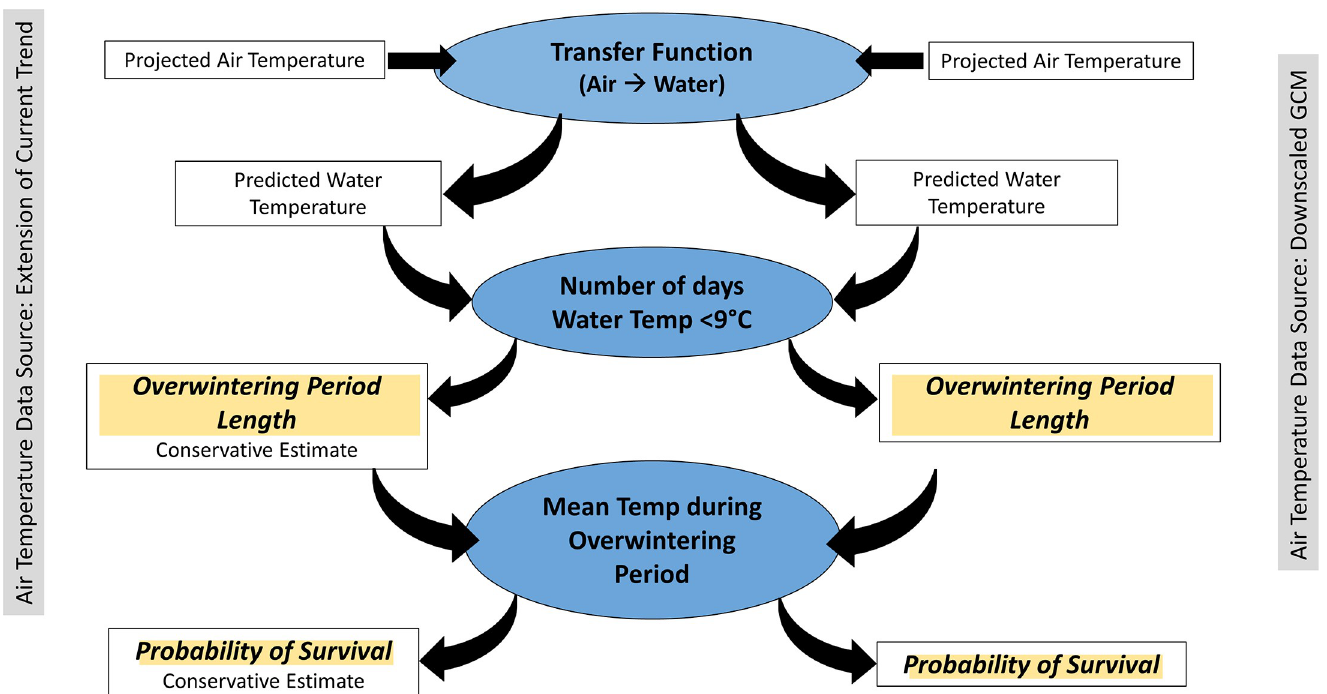
Fig 1. Schematic of the utilization of the transfer function to predict the length of the overwintering period and the winter survival of blue crab through the year 2100. Daily projected air temperature was accessed from two sources: a conservative extension of the observational trend of increasing water temperature in the historical data (left side of figure) and a multi-model ensemble of downscaled CGM projections (right side of figure). The projected air temperature time series were used with the transfer function to predict future water temperature based on those two data sources. The number of days below 9˚C for each source of future temperature data was used as a proxy for the overwintering period of crabs under both the conservative (extension of the observational data trend) and the downscaled GCM warming scenarios. The mean temperature during the overwintering period was used in conjunction with the length of the overwintering period to predict the probability of overwinter survival for each warming